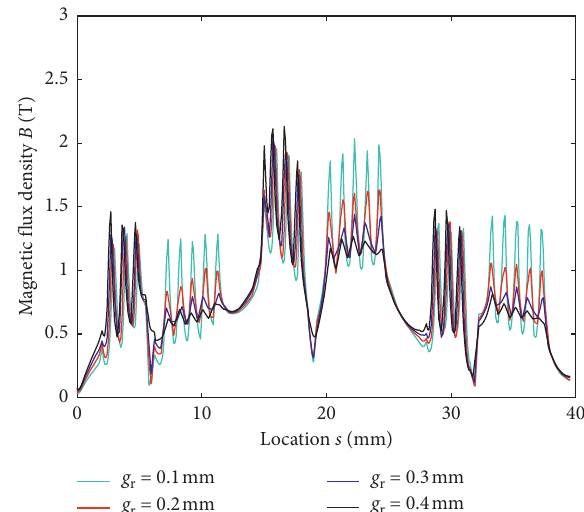
Figure 5: Magnetic field distribution with different radial sealing position heights. g : radial sealing position height. r